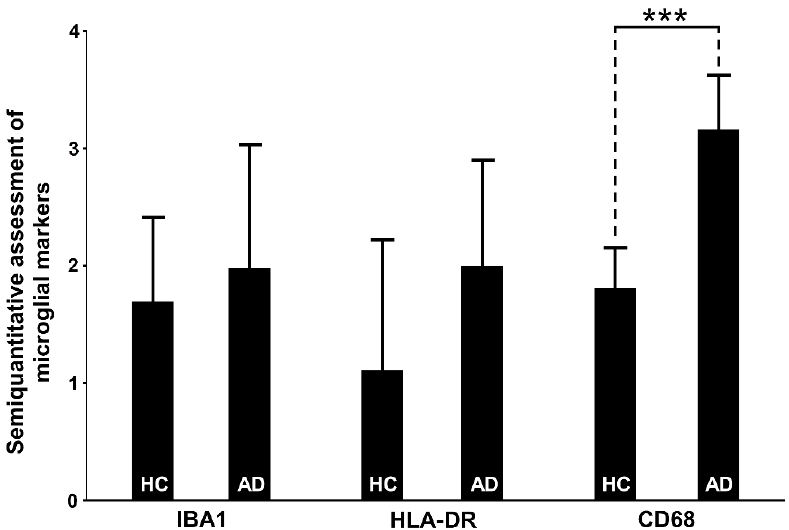
Figure 4. Semiquantitative assessment of IBA1/HLA-DR/CD68 immunoreactive microglial cells per randomly selected section in healthy control (HC) and Alzheimer’s disease (AD) subjects across the hippocampus. Microglial markers were analyzed for IBA1 and HLA-DR according to the following scale: 0—immunoreactivity is not present; 1—several immunoreactive cells are present, all cells are ramified microglia; 2—moderate number of immunoreactive cells, mostly ramified, few activated cells; 3—many diffusely distributed immunoreactive cells, mostly activated; and 4—many large clusters of activated microglial cells; marker CD68 was analyzed according to the following scale: 0—immunoreactivity is not present; 1—several immunoreactive cells are present; 2—moderate number of immunoreactive cells; 3—many diffusely distributed immunoreactive cells; and 4—many large clusters of immunoreactive microglial cells. CD68 expression is significantly higher in the AD group compared to HC (T = − 7.22, d.f. = 18, with pooled estimate of variance p < 0.001). Data are represented as means ± SD. *** = p <